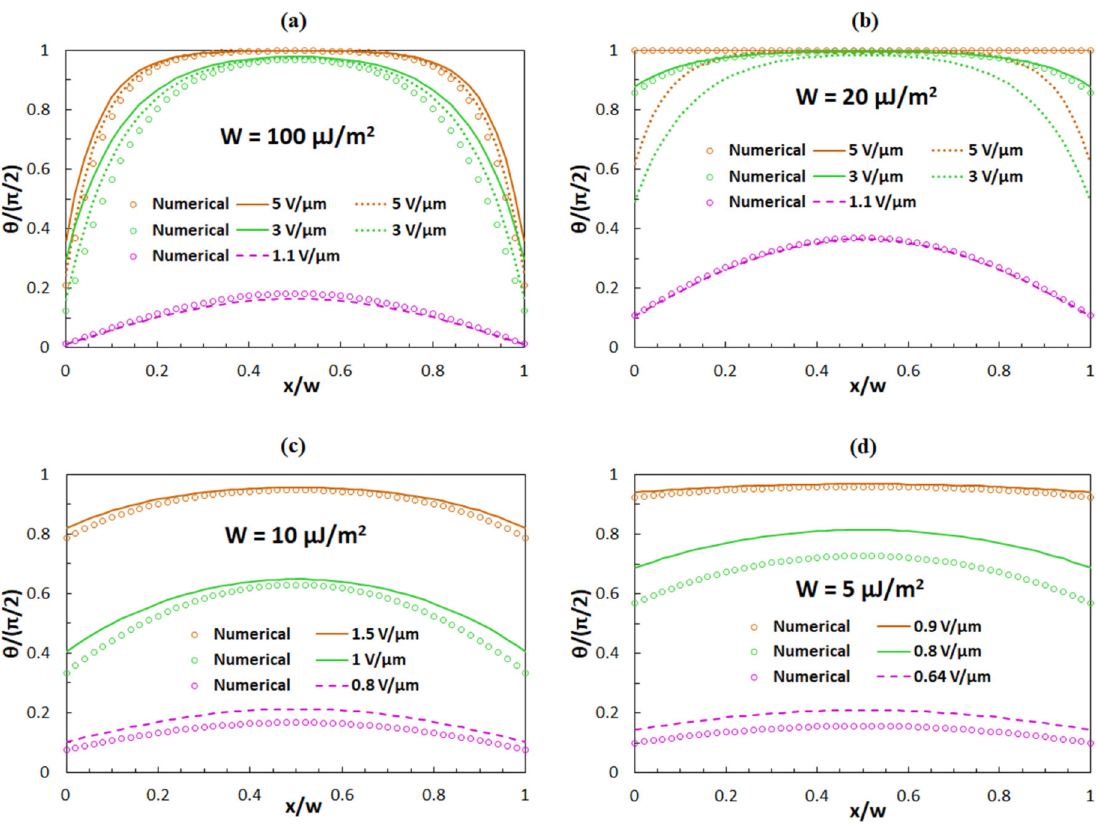
Figure 5. Numerical and analytical results for θ ( x ) for anchoring strengths of ( a ) W = 100 µ J/m 2 , ( b ) W = 20 µ J/m 2 , ( c ) W = 10 µ J/m 2 and ( d ) W = 5 µ J/m 2 . Circles correspond to the numerical solution, dotted lines to Equation (9), solid lines to Equation (10) and dashed lines to Equation (13). The results are given for three different values of the electric